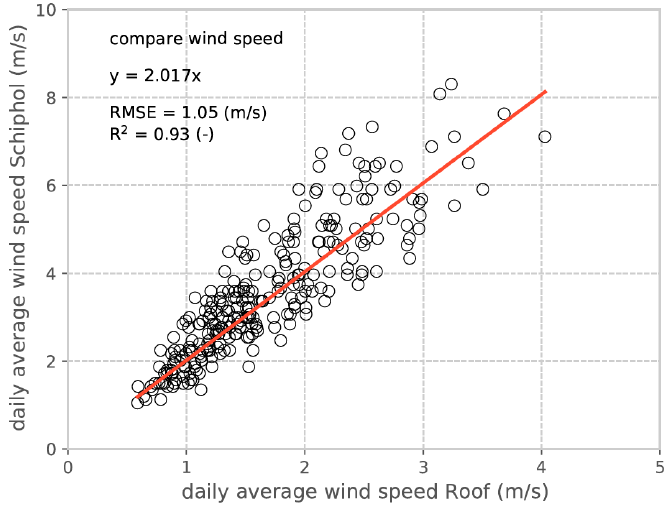
Figure A3. Comparison between the daily averaged wind speed at the research site (roof) and the daily averaged wind speed at Schiphol after correction for the measurement height.